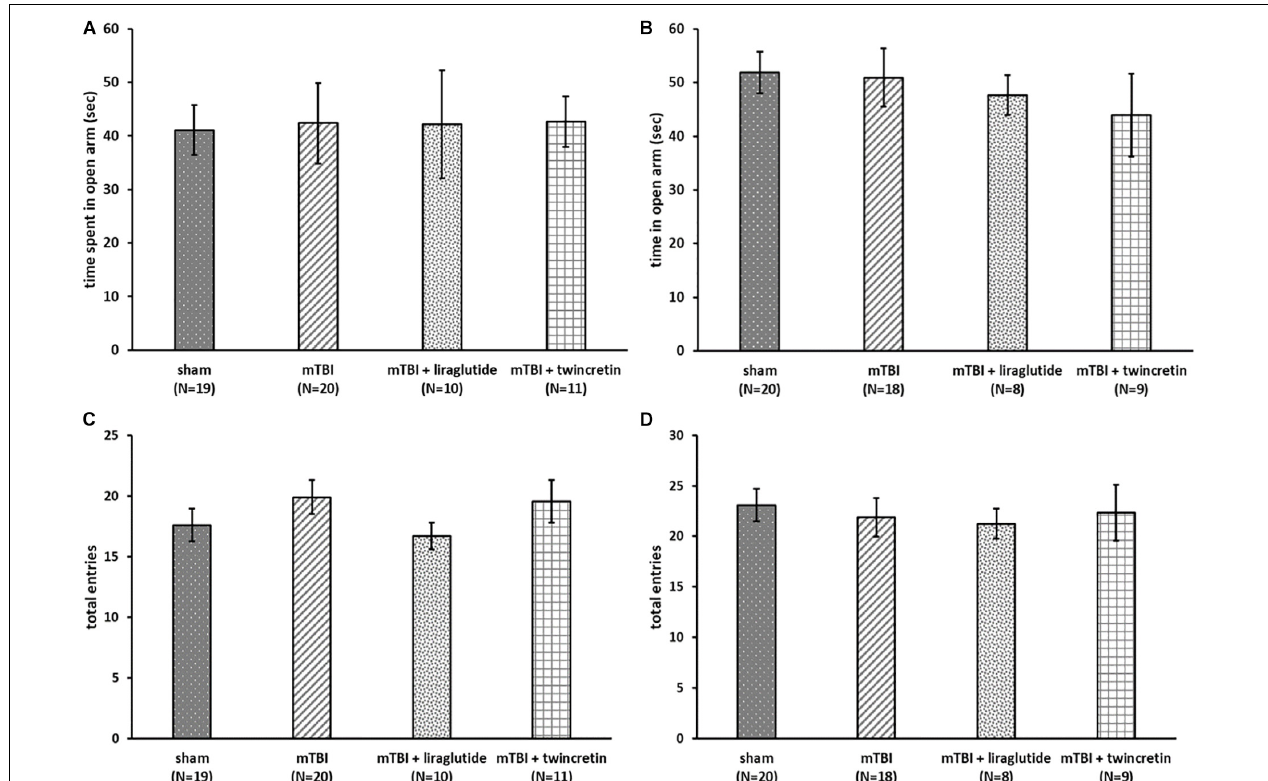
FIGURE 2 | mTBI exposure and liraglutide/twincretin treatment do not impact the overall condition of the mice, as assessed in the elevated plus maze at both 7 and 30 days post trauma. Anxiety-like behavior assessment at 7 (A) and 30 (B) days post injury. The time spent in open arms of the maze was recorded and compared between groups. One-way ANOVA analysis showed that there were no differences between groups and that all groups of mice spent equivalent times in the open arms at both 7 and 30 days post mTBI [ A: F (3,56) = 0.064; NS and B: F (3,51) = 0.374; NS]. Values are mean ± SEM. Locomotor activity at 7 (C) and 30 (D) days post injury. The number of total entrances to the arms of the maze was recorded and compared between groups. One-way ANOVA analysis demonstrated that there were no differences between the groups and all groups of mice had an approximately equal number of entrances to the arms at both 7 and 30 days post mTBI [ C: F (3,56) = 0.830; NS, and D: F (3,51) = 0.218; NS]. Values are mean ±